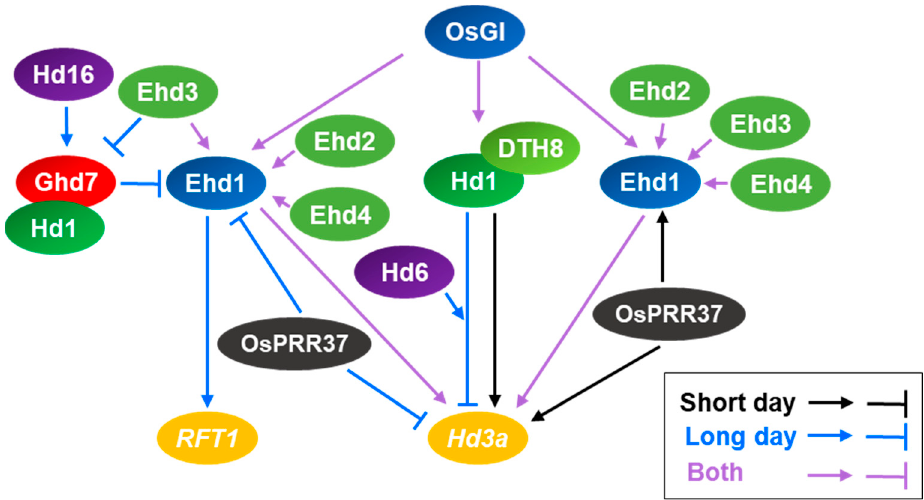
Figure 2. The regulatory network controlling Hd3a and RFT1 expression in rice. Flowering is regulated by two distinct pathways in rice, Hd1-Hd3a and Ghd7-Ehd1-Hd3a/RFT1 . Under short-day conditions, Hd1 positively regulates Hd3a expression. DTH8 interacts with Hd1 to help upregulate Hd3a expression. The expression of Ehd1 , which encodes another activator of Hd3a , is induced by Ehd2, Ehd3, and Ehd4 regardless of photoperiod. Under long-day conditions, Hd1 is converted to a negative regulator of Hd3a expression. Hd6 enhances the negative function of Hd1 on the Hd3a expression under long day conditions. In addition, Ghd7 acts as a repressor of Ehd1 expression, leading to the suppression of RFT1 expression. The Ghd7-dependent suppression of Ehd1 expression is enhanced by Hd16 . Hd1 physically interacts with Ghd7 to repress Ehd1 expression under long-day conditions. OsPRR37 affects flowering by suppressing the transcription of Ehd1 and Hd3a under long day conditions, but activating expression of Ehd1 and Hd3a under short day conditions.